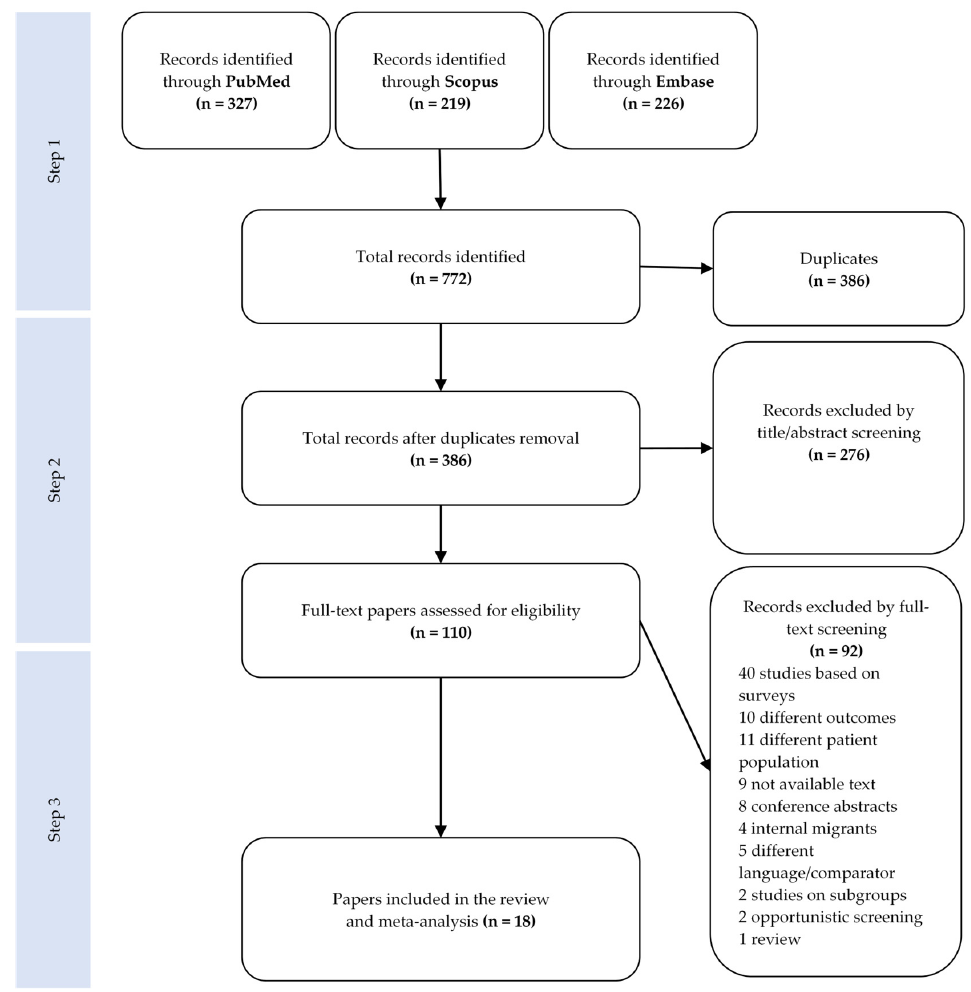
Figure 1. PRISMA flowchart for the paper selection process. Table 2. Characteristics of the included